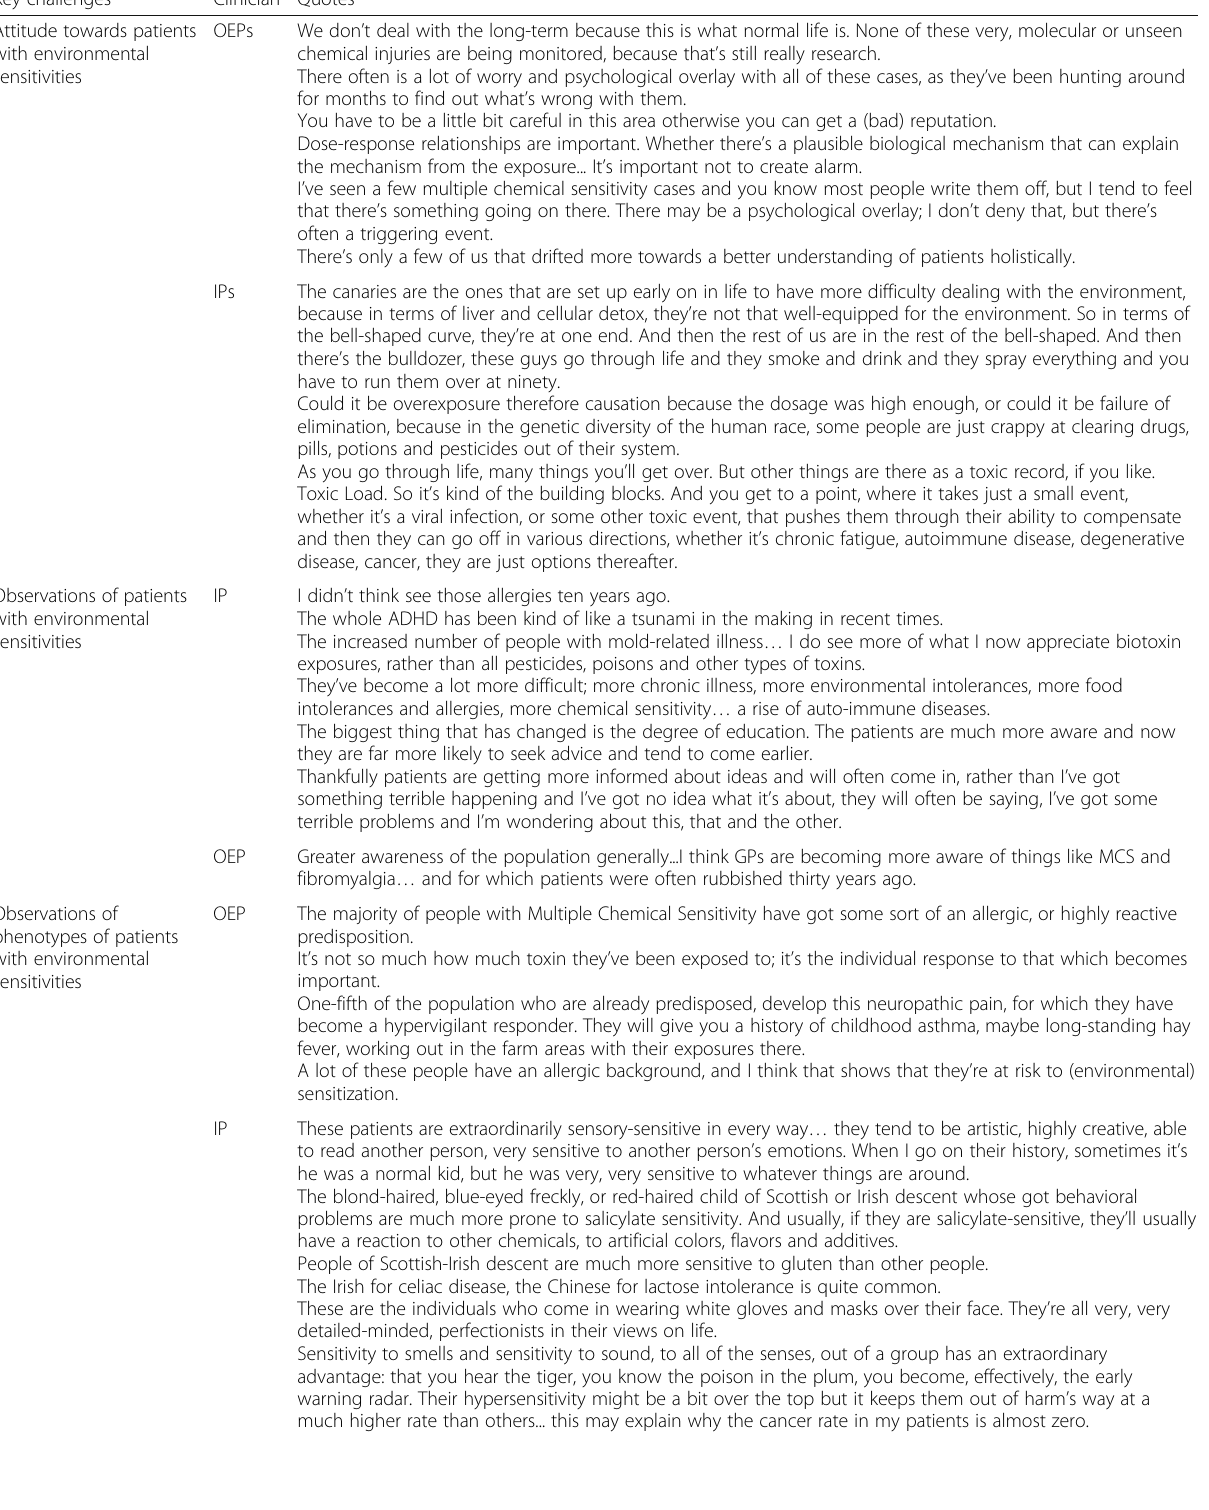
Table 4 Patients with environmental sensitivities have unique phenotypes, are complex to treat, rarely regain full health and are becoming more